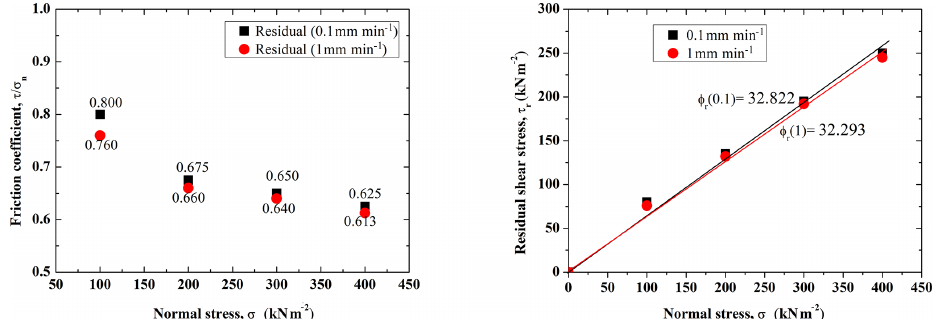
Figure 10. Relationships between residual shear stress and normal stress and residual strength parameter for the DBZ soil sample.